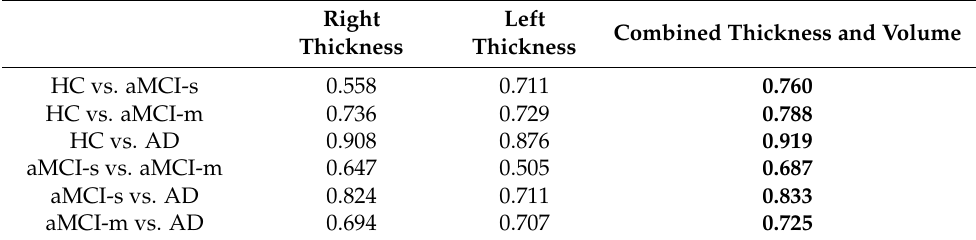
Right Left Thickness